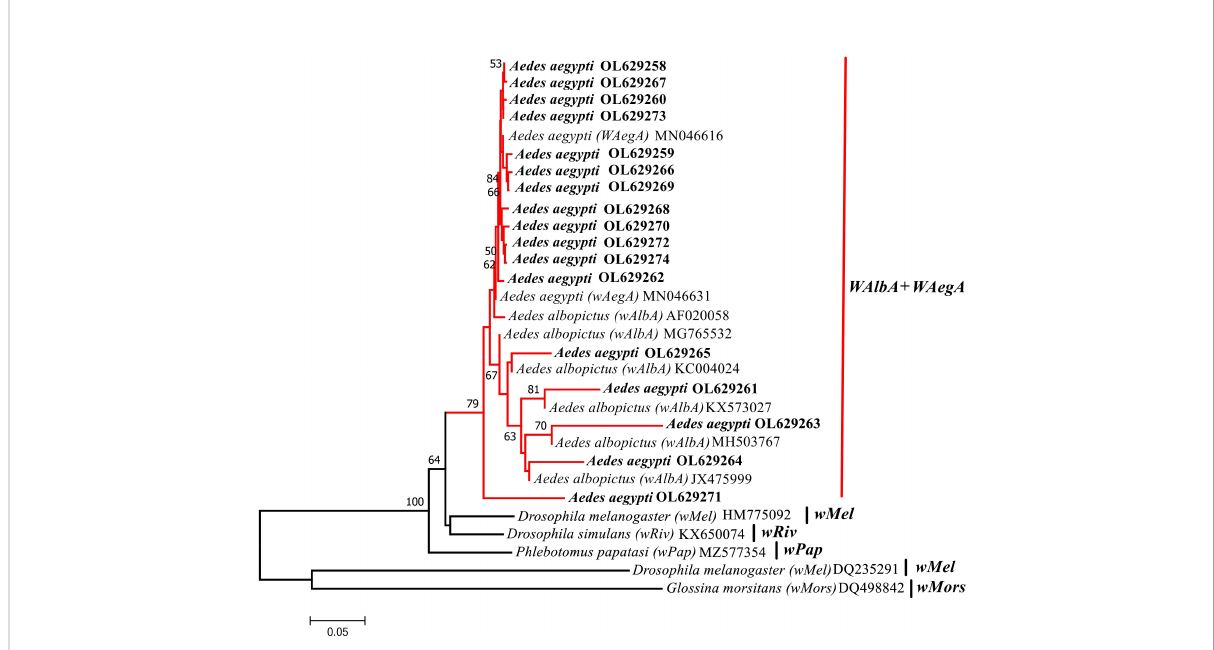
FIGURE 3 Phylogenetic tree analysis by the neighbor-joining method using the wsp gene (A supergroup primers: 136F,691R). The tree contains 30 nucleotide sequences. 17 from this study and 13 from GenBank searches with Bootstrap values (1000 replicates) marked next to the branches. Taxa were tagged to obtain the host name of the Wolbachia strain and the ID in GenBank. the wsp sequences in this study all start with Aedes aegypti OL. OL629258 to OL629262 belong to JHGZ, Xishuangbanna prefecture. OL629263 to OL629265 belong to JHDM, Xishuangbanna prefecture. OL629266 belongs to JHFZ, Xishuangbanna prefecture. OL629267 and OL629268 belong to JHML, Xishuangbanna prefecture. OL629269 to OL629271 belong to DLAA, Xishuangbanna prefecture. OL629272 belongs to DLXX, Xishuangbanna prefecture. OL629273 belongs to JHJL, Xishuangbanna prefecture. OL629274 belongs to JGLS, Dehong prefecture. The reference sequences used are shown in Table